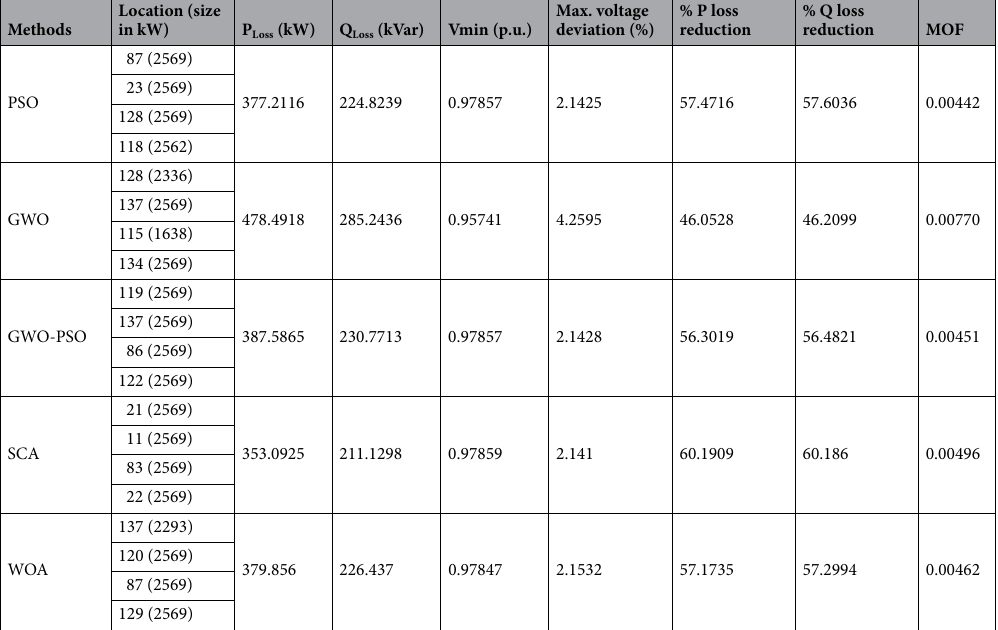
Table 6. Performance measurement after the integration of 4-DGs with different algorithms.